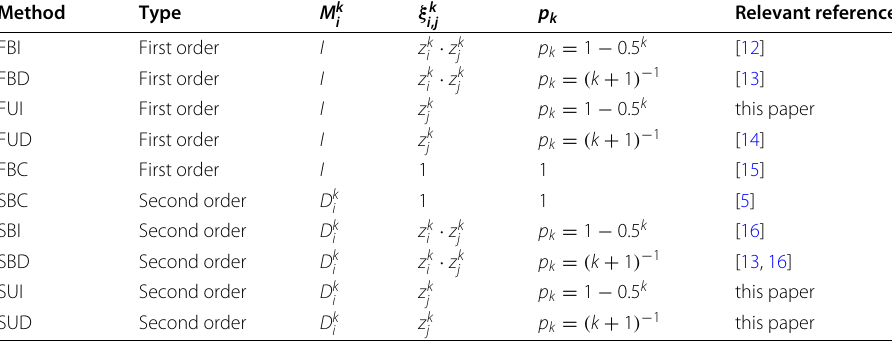
Table 1 Different alternatives of Algorithm